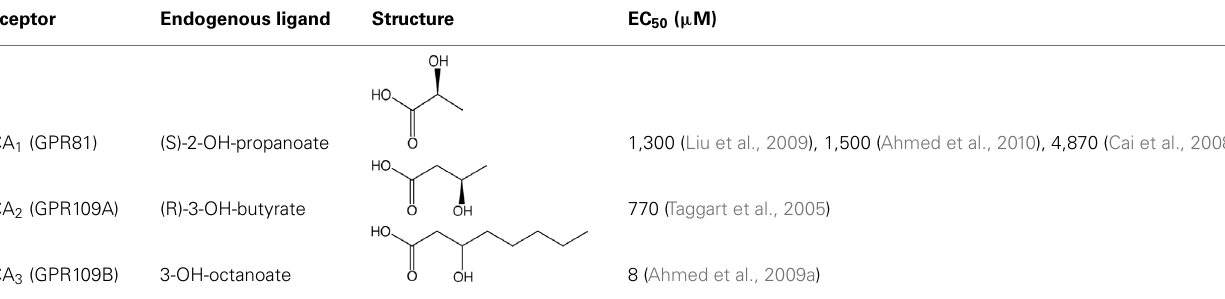
Table 1 | Structures and EC 50 values of endogenous ligands of HCA receptors. EC 50 values were determined by ligand-induced GTP γ S-binding assay.